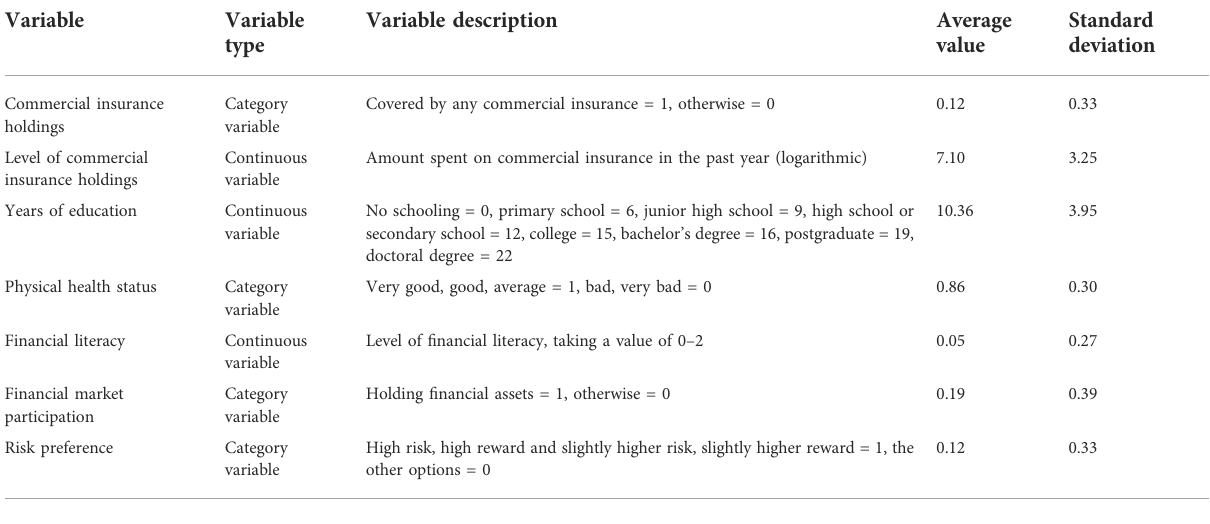
TABLE 1 Description of variables and descriptive statistics.